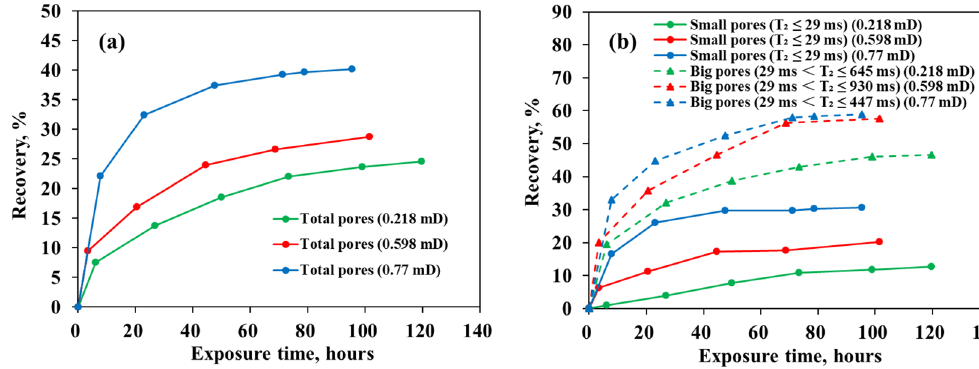
Figure 2. The relationships between recovery and exposure time for three cores with different permeability: ( a ) total pores; ( b ) small pores and big